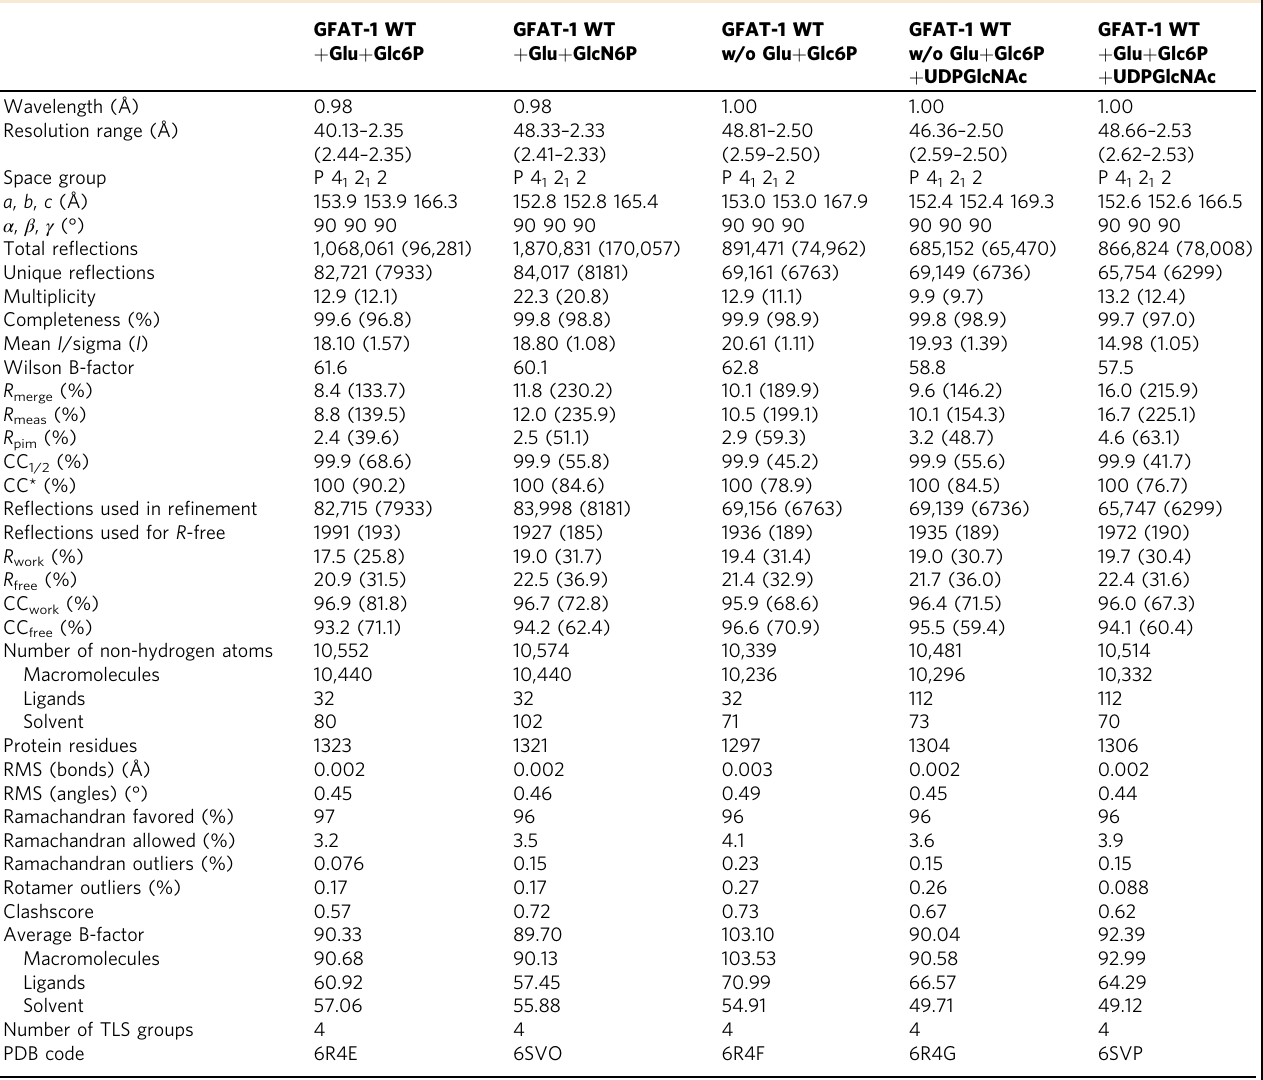
Statistics for the highest-resolution shell are shown in